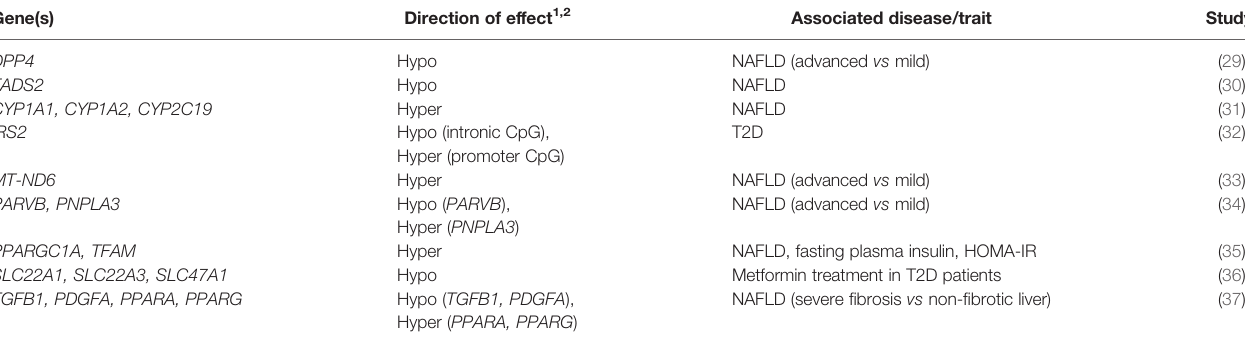
TABLE 1 | Genes investigated in targeted and candidate gene studies in liver DNA methylation studies of IR-related diseases. Gene(s)